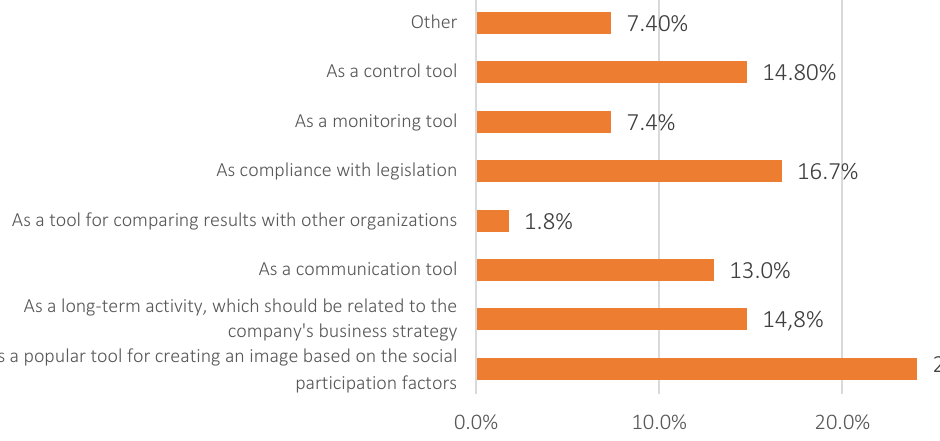
Figure 1. Forms of the corporate social responsibility